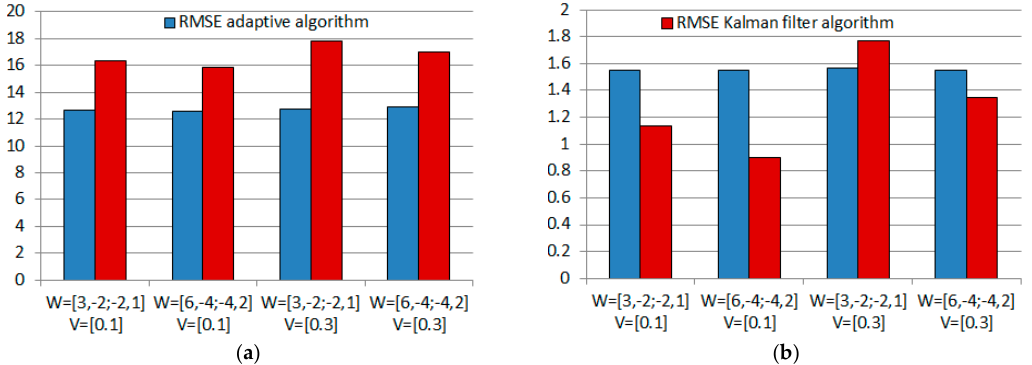
Figure 12. Root-mean-squared error (RMSE) quality indicators BOD ( a ) and DO ( b ) signals generated.